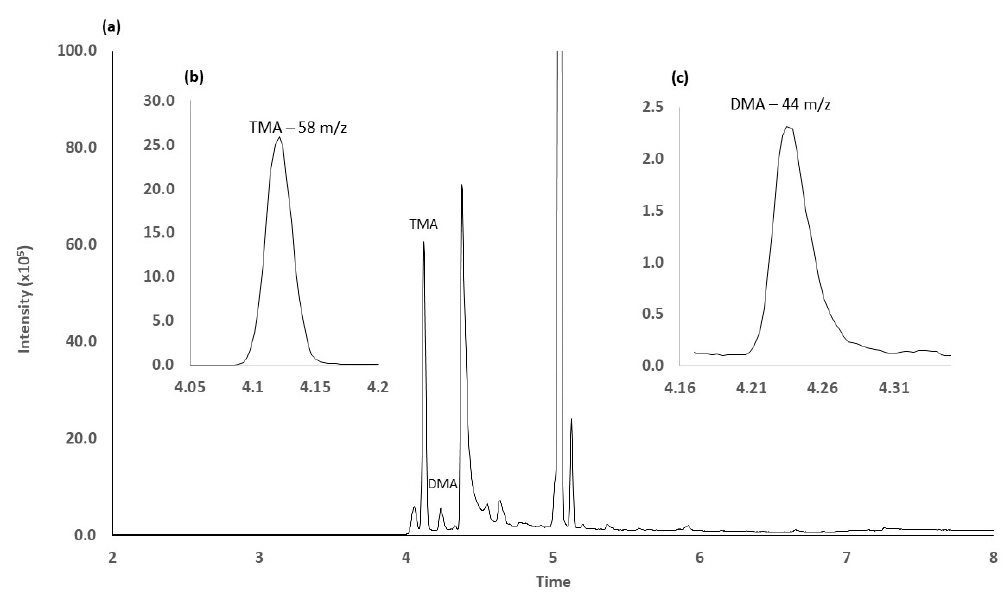
Figure 5. Chromatographic profile of targeted amines with the optimal method conditions ( a ) total ion chromatogram results; ( b ) TMA ion selection 58 m/z. ( c ) DMA ion selection 44 m/z.